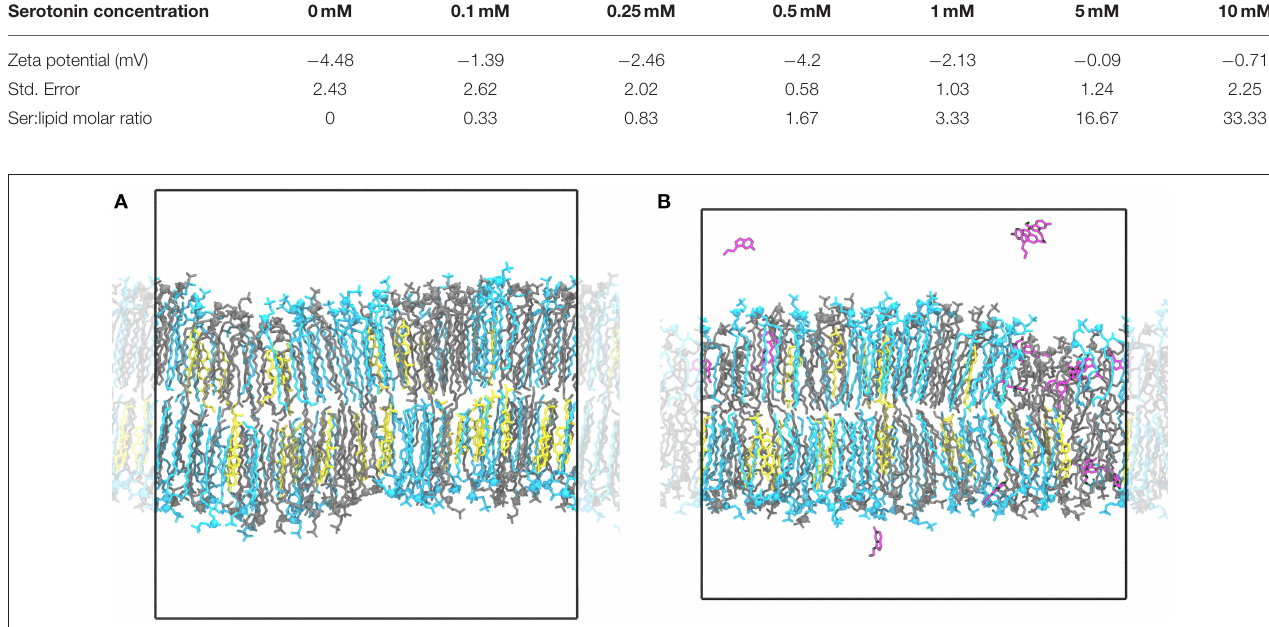
TABLE 2 | Zeta potential of a POPC/PSM/Chol 4/4/2 membrane for different serotonin concentrations. Serotonin concentration